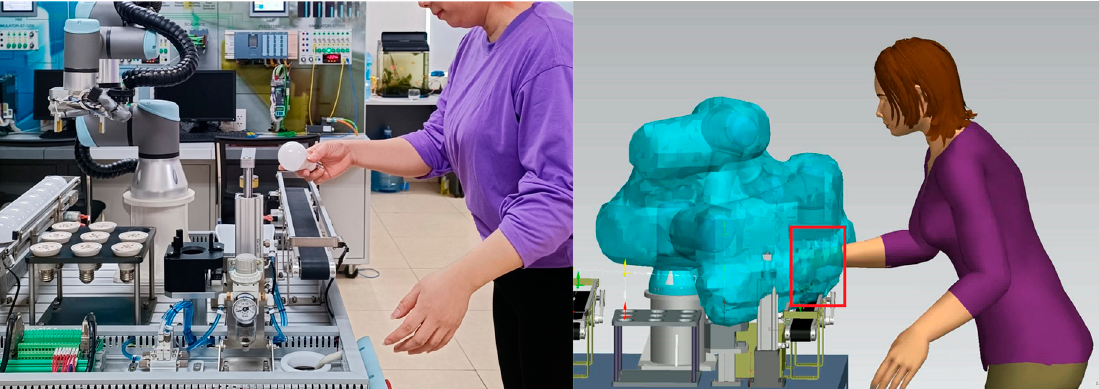
Figure 3. Real human and robot image ( on the left )—human and robot in Tecnomatix software ( on the right ).